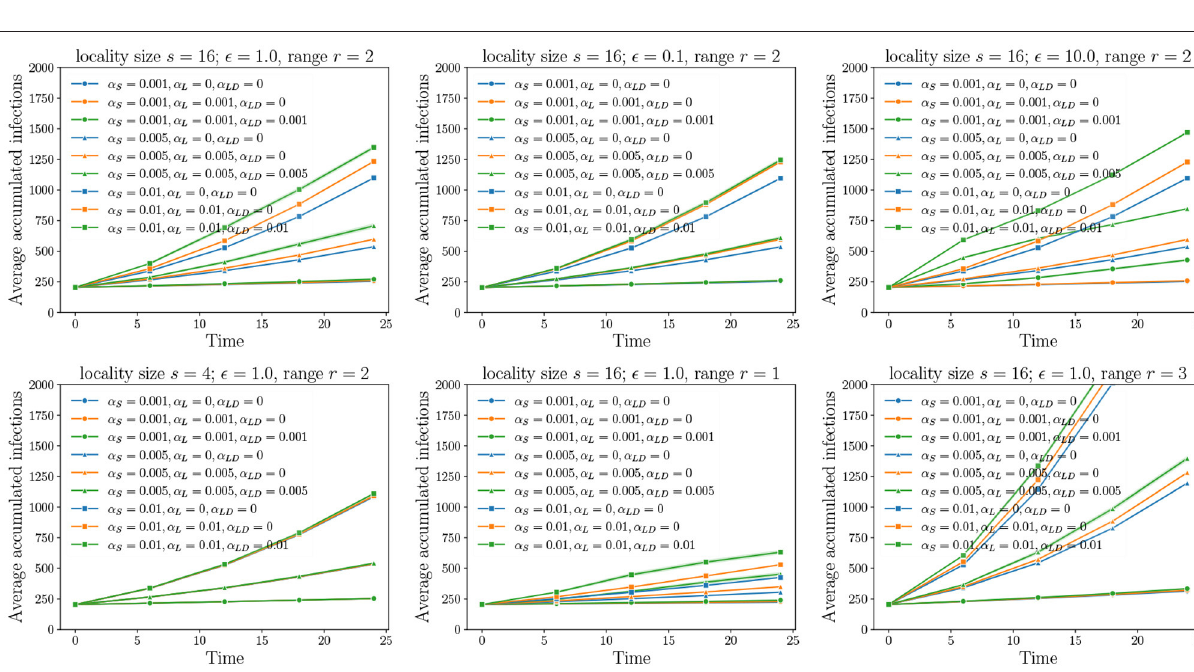
c , α ℓ c , α ℓ d 0), and finally, = = =